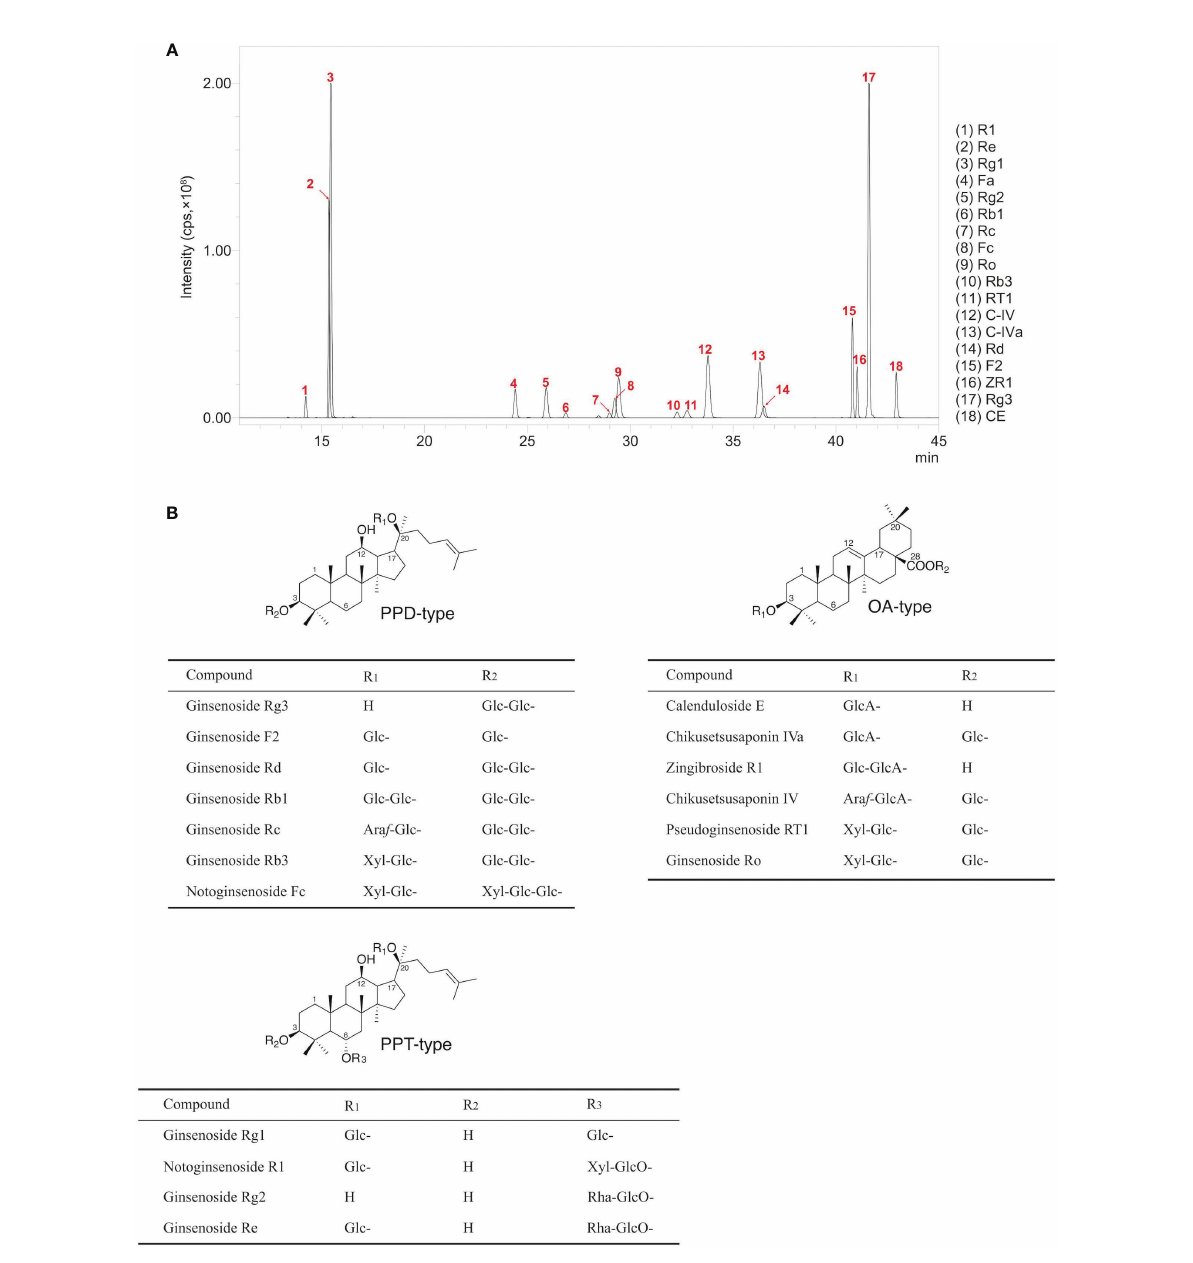
FIGURE 1 LC-MS result of ginsenoside extracts from four tissues of P. japonicus . (A) Total ion chromatogram of 18 ginsenosides. Notoginsenoside R1 (R1, PPT-type); Ginsenoside Re (Re, PPT-type); Ginsenoside Rg1 (Rg1, PPT-type); Notoginsenoside Fa (Fa, PPD-type); Ginsenoside Rg2 (Rg2, PPT-type); Ginsenoside Rb1 (Rb1, PPD-type); Ginsenoside Rc (Rc, PPD-type); Notoginsenoside Fc (Fc, PPD-type); Ginsenoside Ro (Ro, OA-type); Ginsenoside Rb3 (Rb3, PPD-type); Pseudoginsenoside RT1 (RT1, OA-type); Chikusetsusaponin IV (C-IV, OA-type); Chikusetsusaponin IVa (C-IVa, OA-type); Ginsenoside Rd (Rd, PPD-type); Ginsenoside F2 (F2, PPD-type); Zingibroside R1 (ZR1, OA-type); Ginsenoside Rg3 (Rg3, PPD-type); Calenduloside E (CE, OA-type). (B) Chemical structures of 18